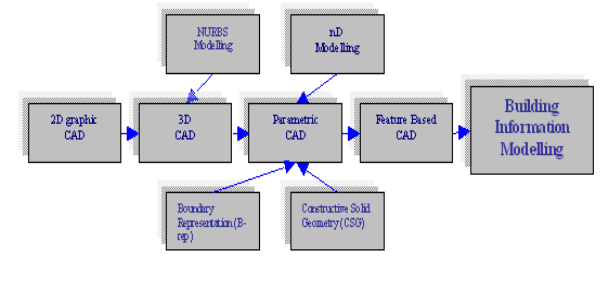
Figure 1 Evolution of